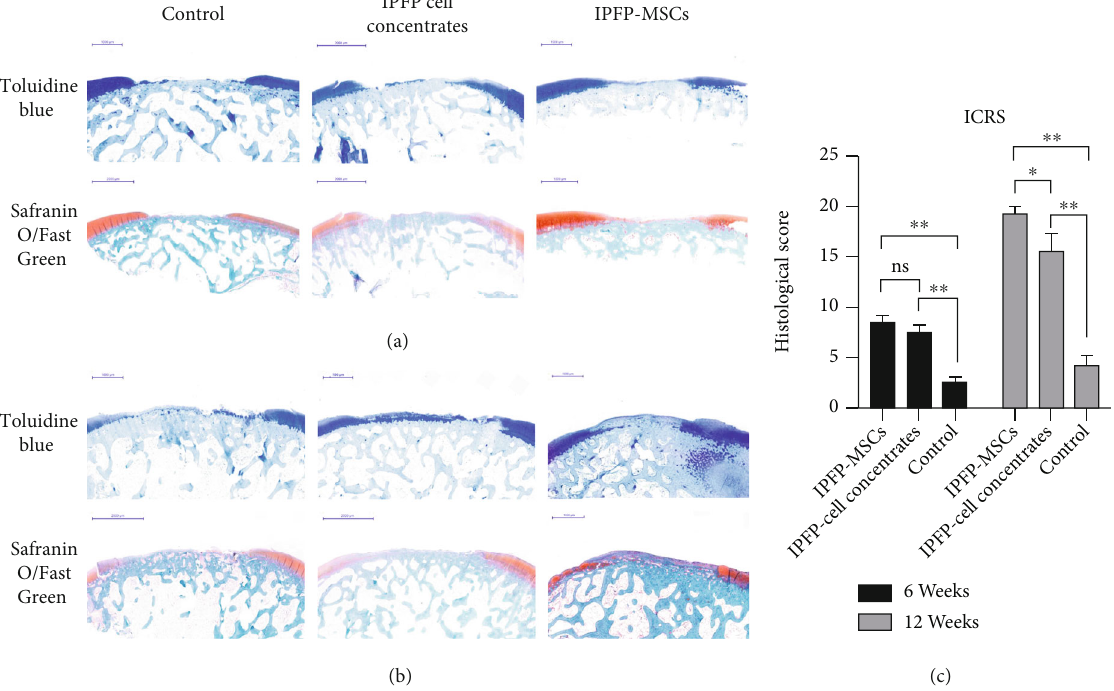
Figure 5: (a, b) Toluidine blue and Safranin O/Fast Green staining of di ff erent groups at 6 and 12 weeks. (c) The ICRS visual histological assessment scores of articular cartilage repair. (All data were expressed as the mean ± SD . Comparisons were performed with the Student t -test or one-way ANOVA for experiments with more than two subgroups. Asterisks indicate signi fi cant di ff erences ( ∗ P < 0 : 05 ; ∗∗ P < 0 : 01 ) compared with the corresponding